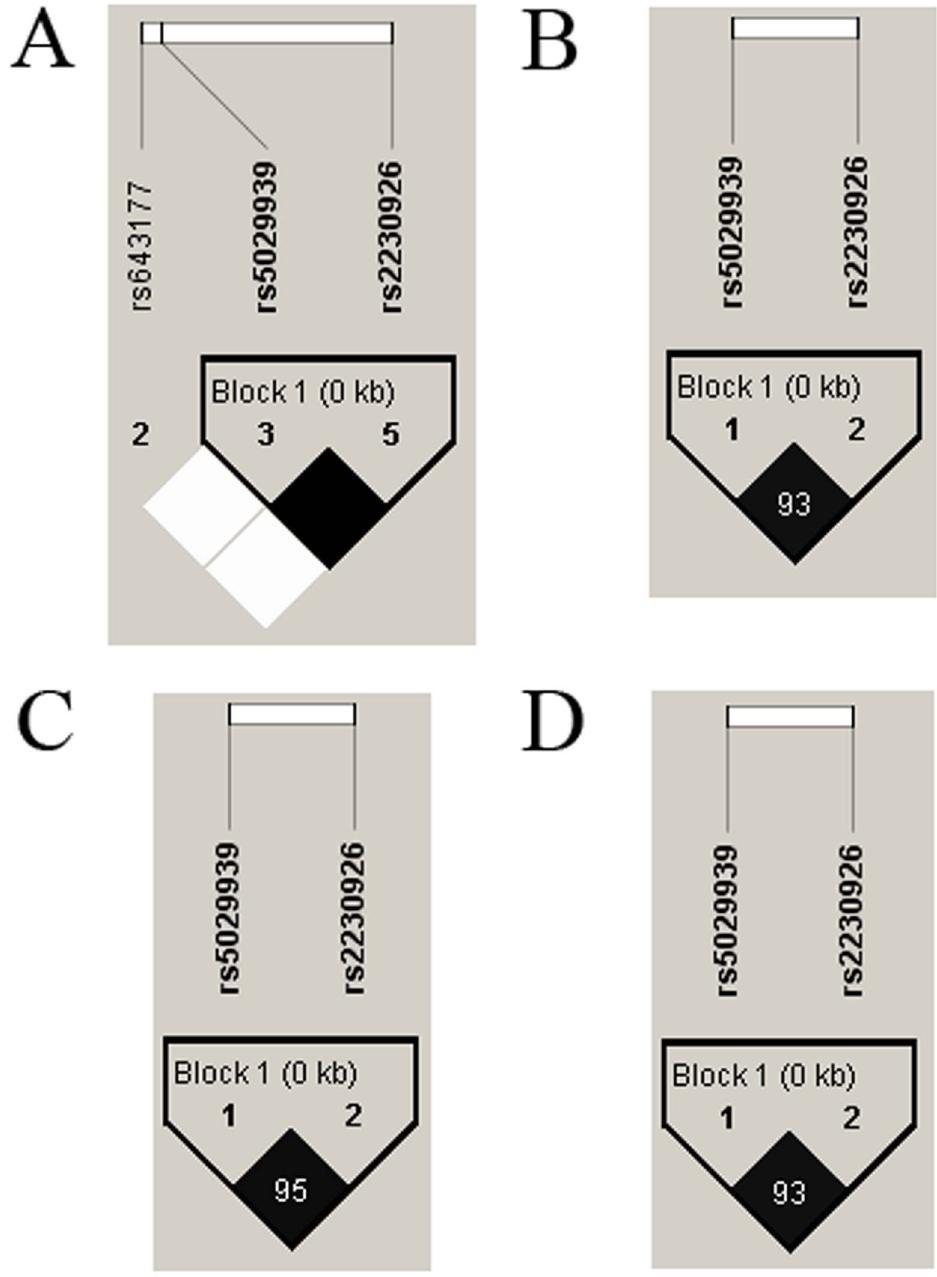
Figure 1. Linkage disequilibrium (LD) analysis of the SNPs in the TNFAIP3 gene region. The LD plots were generated by Haploview software v4.2 and data from our study were similar to that from the HapMap CHB population. The number (divided by 100) in the small square represents r 2 value and ranges from 0 to 1. The two SNPs (rs2230926 and rs5029939) in TNFAIP3 reside in an LD block. (A): The data from HapMap CHB. B: The data analysis between DM patients and healthy controls from our study. C: The data analysis between PM patients and healthy controls from our study. D: The data analysis between PM/DM patients and healthy controls from our study.